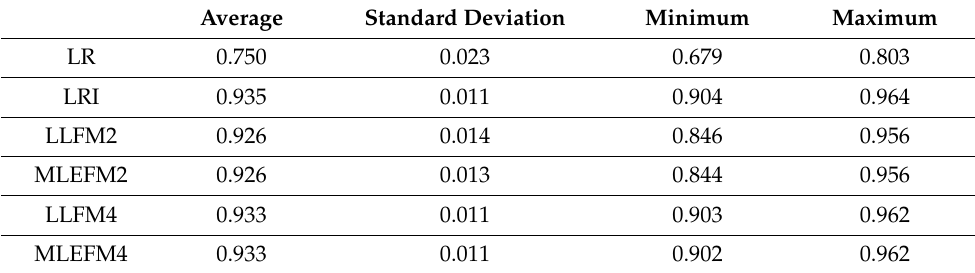
Table 8. Gini coefficients obtained by the models over simulation runs.